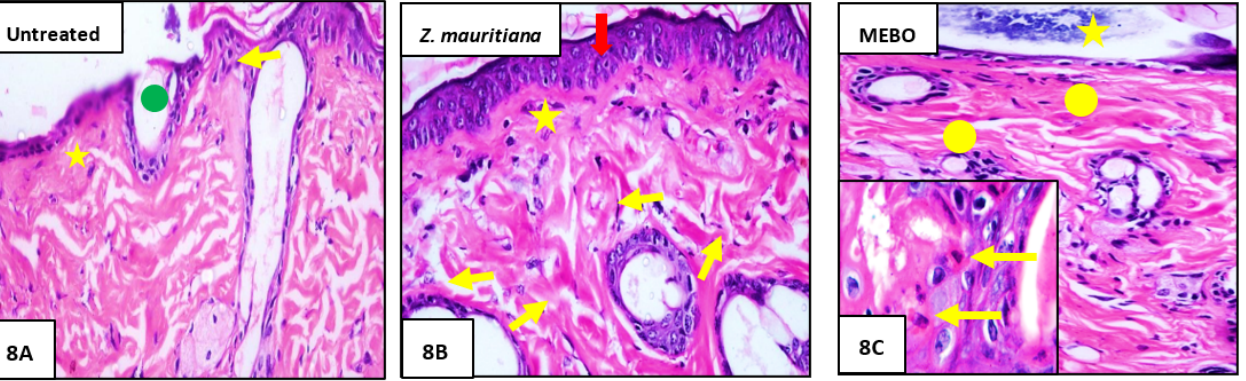
Figure 8. Histograms of wounded skin on day 7 after incision: ( A ) of Group 1 (untreated) showing the normal edge of the wound with the normal epidermis (yellow arrow) the wound is filled with blood clots (green circle) and underlying sloughed granulation tissue with compact and irregular collagen bundles (yellow star); ( B ) of Group 2 ( Z. mauritiana fruits extract) showing marked re-epithelization (red arrow), granulation tissue filling the base of the defect from below is mainly cellular (star), and collagen bundles as appear as disorganized coarse and wavy bundles (yellow arrows). ( C ) of Group 3 (MEBO ® -treated) showing scar tissue blocking the wound (star), Collagen bundles packing the defect in a reticular pattern resembling that of the adjacent normal dermis (circle). The inset shows inflammatory cellular infiltration mainly macrophages (yellow arrows). (Hematoxylin and eosin stain × 200 and 400).